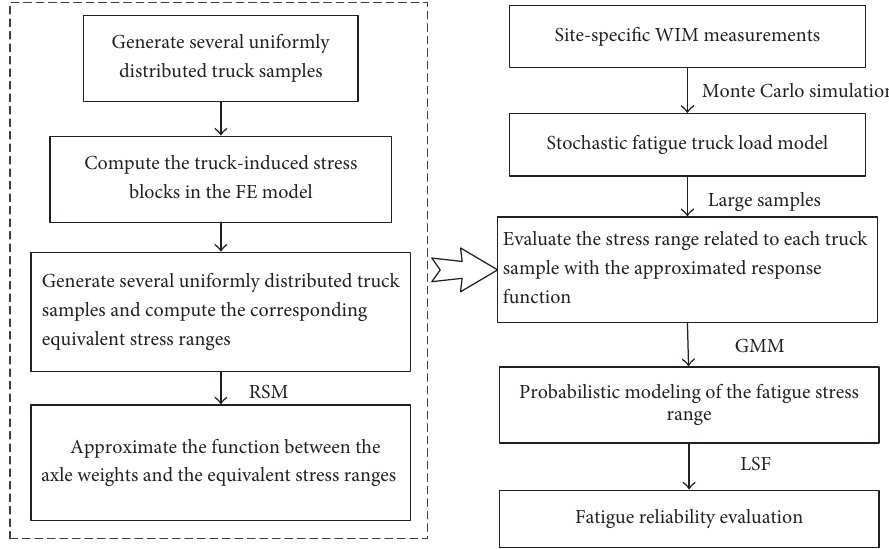
Figure 4: Flowchart of the proposed computational